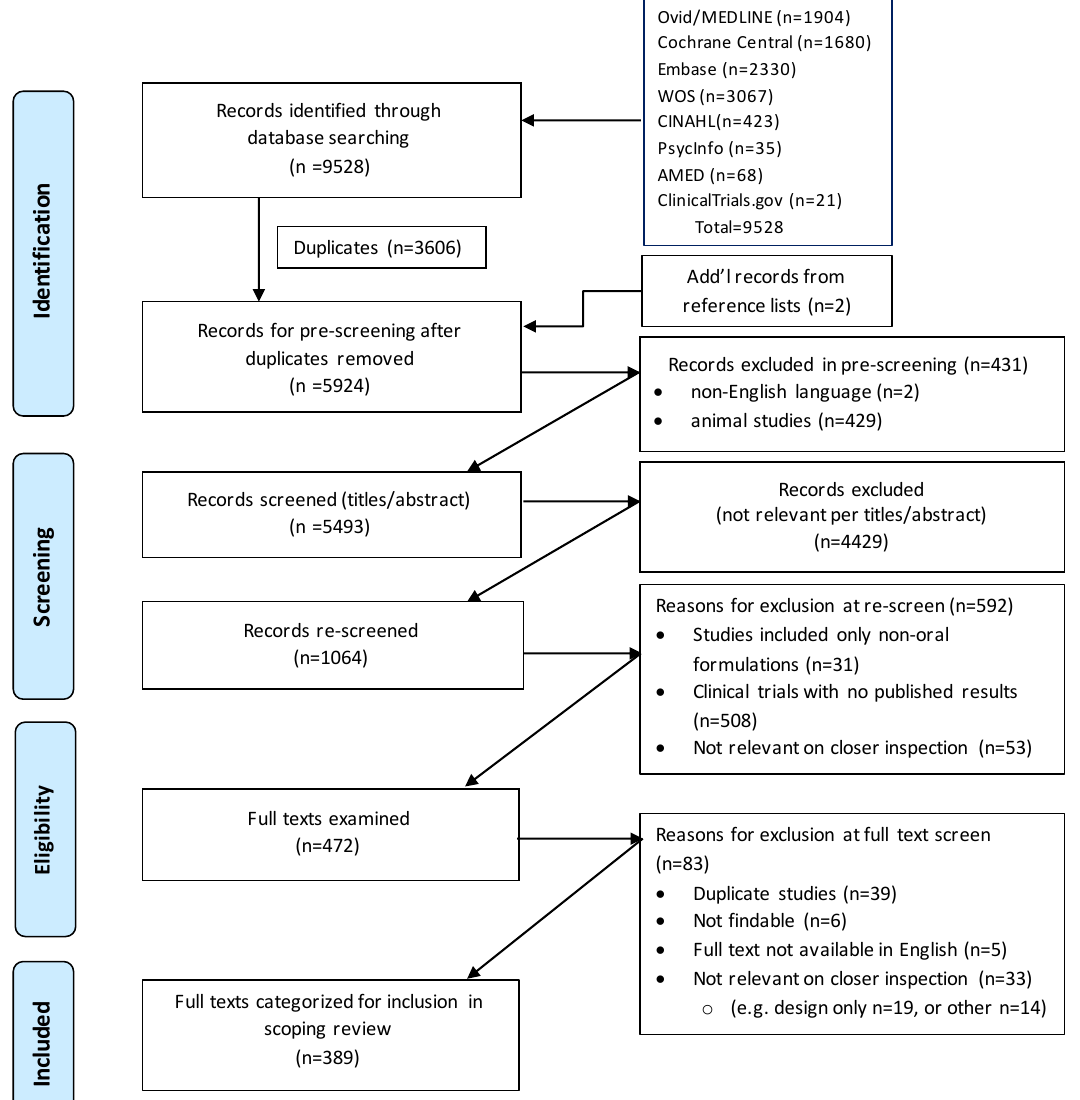
Figure 2. Preferred Reporting Items for Systematic Reviews (PRISMA) flow diagram of scoping review process used to search literature and extract citations meeting inclusion criteria. See Figure 3.